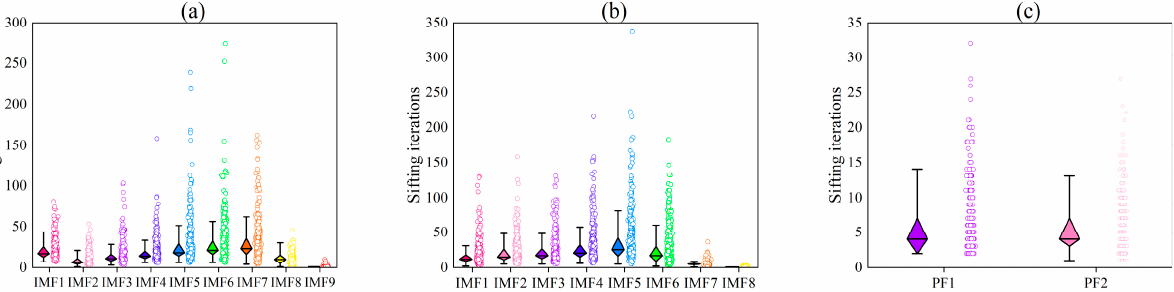
Figure 3. The sifting iterations obtained by ( a ) CEEMDAN ( b ) ICEEMDAN and ( c ) CCERLMDAN. The residual noise in CCERLMDAN and the other two approaches were used for further comparison. The reconstruction errors of the CCERLMDAN and the other two approaches are shown in Figure 4, which are similar in magnitude (orders of 10 − 16 ,10 − 17 and 10 − 17 , respectively), but the CCERLMDAN method is closer to zero.